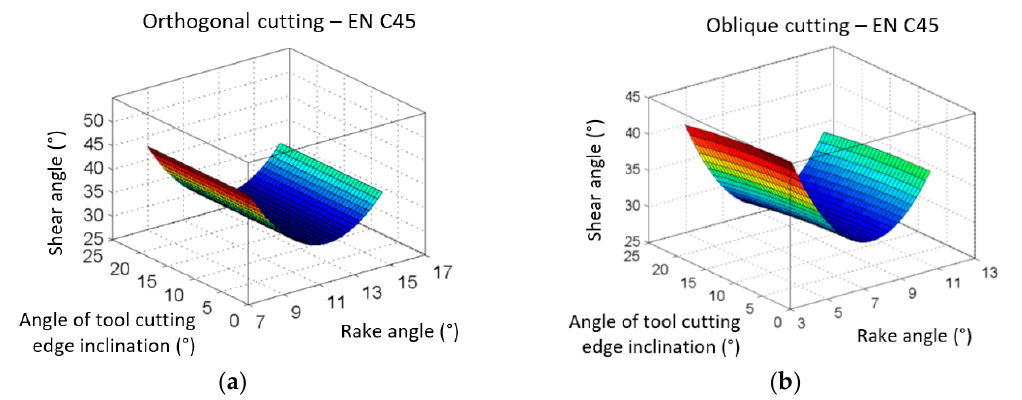
Figure 17. The dependence of shear angle Φ on rake angle γ and on the angle of tool cutting edge inclination λ s ; ( a ) orthogonal cutting; ( b ) oblique cutting.